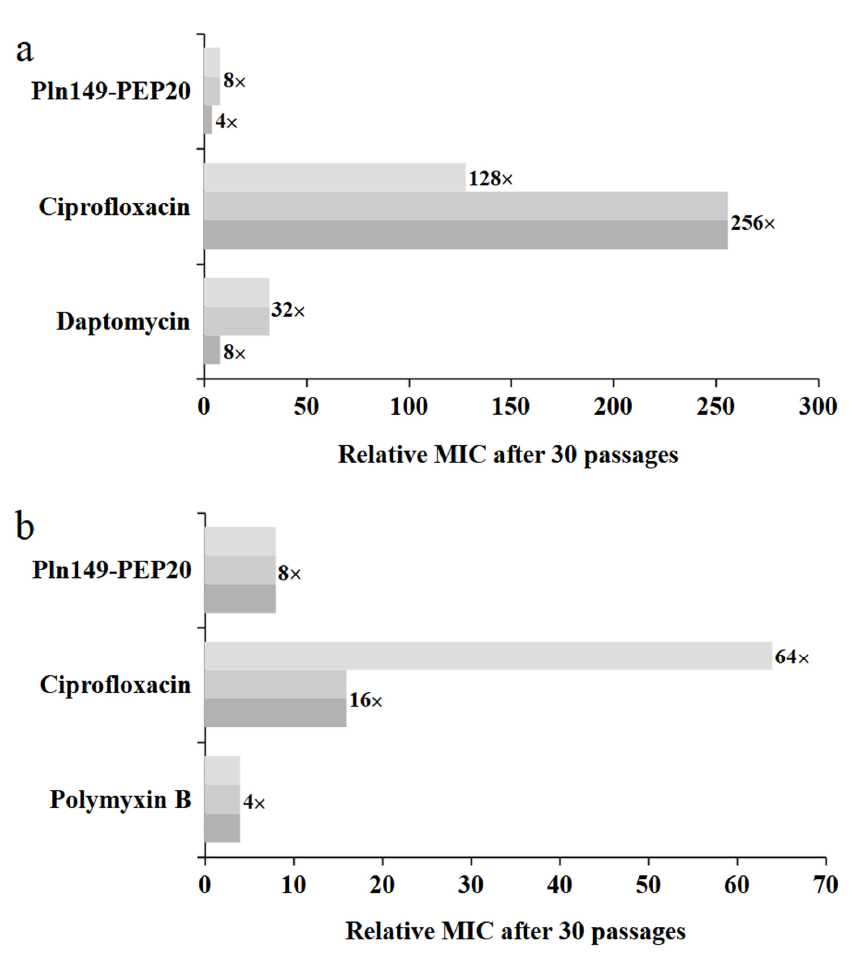
Figure 8. Relative MIC increase for each 30-day exposure, including exposure with Pln149-PEP20, each replicate represented in a shade of gray. ( a ) S. aureus ATCC 25923 ( b ) A. baumannii ATCC 19606. The initial and final strains with reduced susceptibility to Pln149-PEP20 were se- quenced to determine whether mutations related to the mode of action occurred. All mu- tations obtained for S. aureus and A. baumannii are listed in Tables 6 and 7, respectively. Table 6. Comparison between the initial and final strains of the S. aureus ATCC 25923 in vitro selec- tion with Pln149-PEP20.